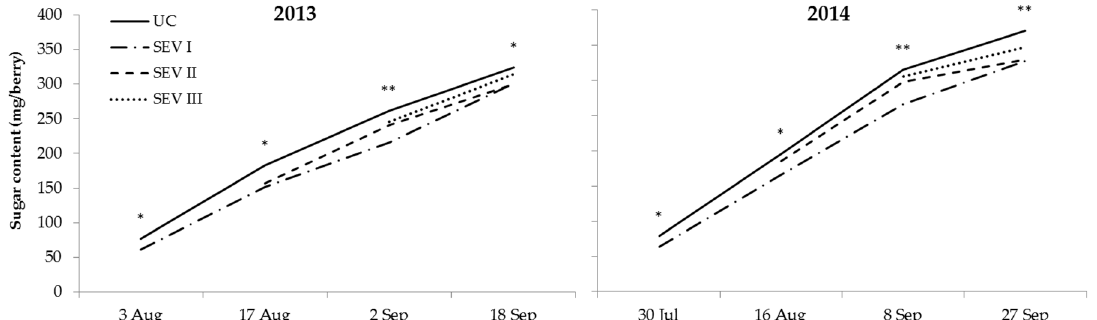
Figure 4. Sugar content in berries (mg/berry) during maturation in seasons 2013 and 2014. UC, untreated control; SEV-I, severe shoot trimming when berries were 4 mm in diameter; SEV-II, severe shoot trimming at early veraison; SEV-III, severe shoot trimming at late veraison. Data were analyzed by one-way ANOVA in randomized blocks design (*, p ≤ 0.05; **, p ≤ 0.01).